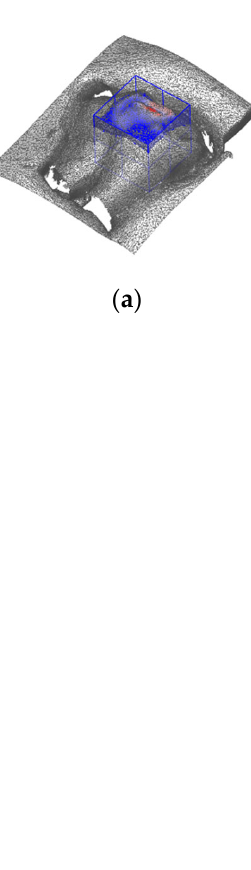
Figure 3. Cube positioning (blue frame) on tooth 21 in T0 condition ( a ), T1 condition ( b ), and T2 condition ( c ).